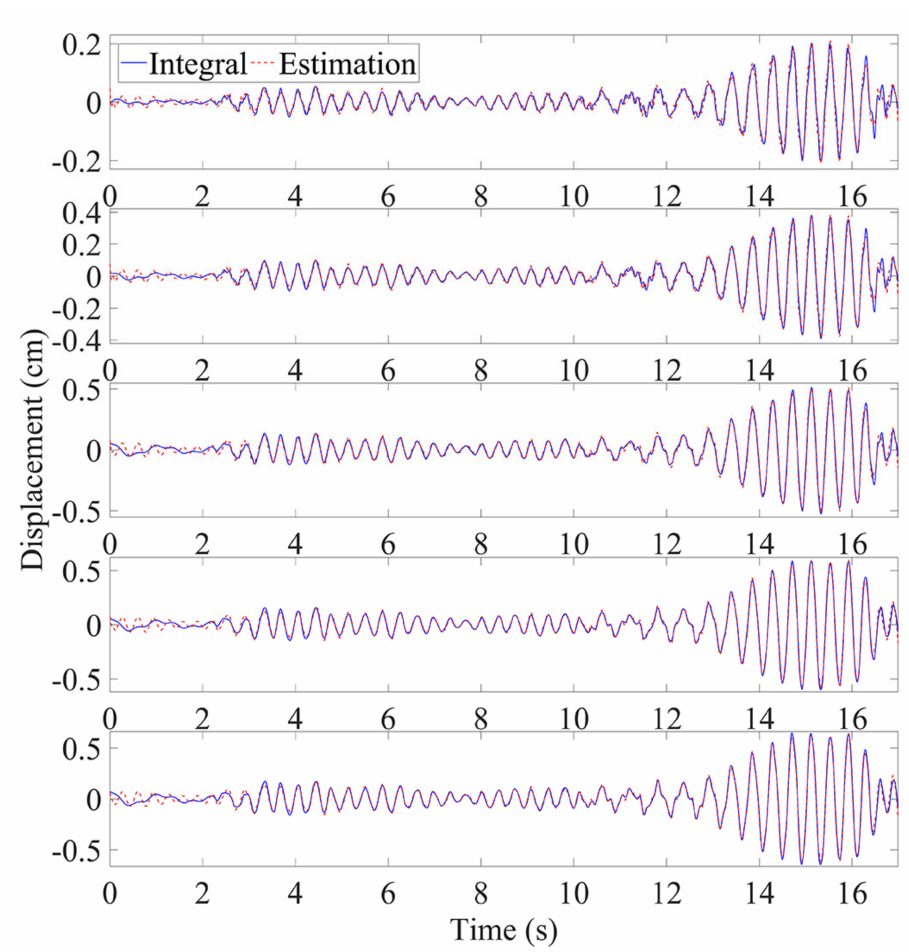
Figure 12. Time histories of relative displacement of five-story frame (first to fifth floor from top to